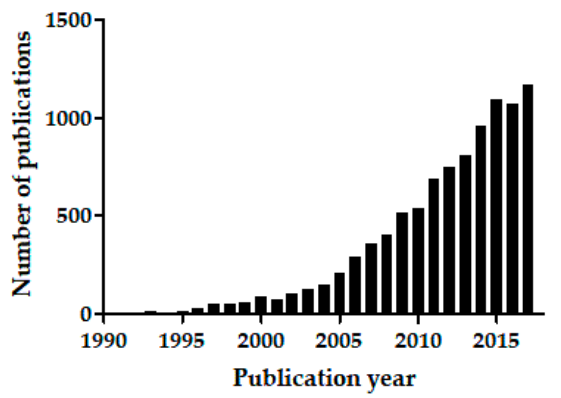
Figure 1. The phrase “aptamer or aptamers” was used as the search term on Pubmed. The number of publications are plotted per publication year.